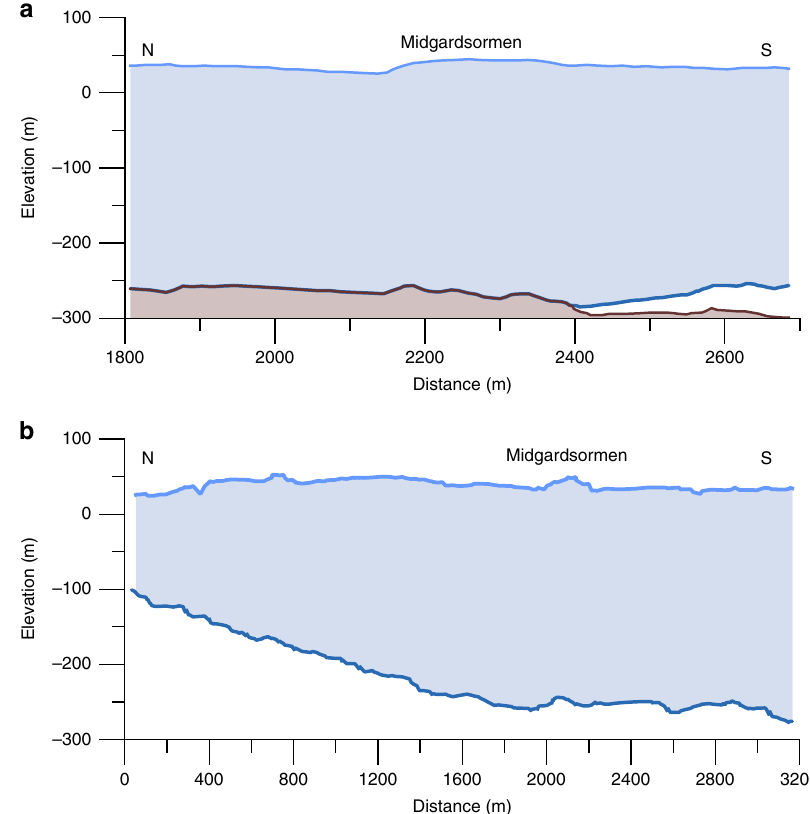
Fig. 3 Glacier geometry along the cross section of GPR and seismic transects. a Cross section of Midgardsormen ridge, as revealed by the seismic measurements in 1998 (location: red dot in Fig. 1). b Glacier geometry along the fi rst 3.2 km of the light blue pro fi le in Fig. 4, according to the airborne radar measurements in 1997. The x -axis coordinates are identical in a and b . The y -axis in a represents the true scale, while the vertical axis is exaggerated three- fold in